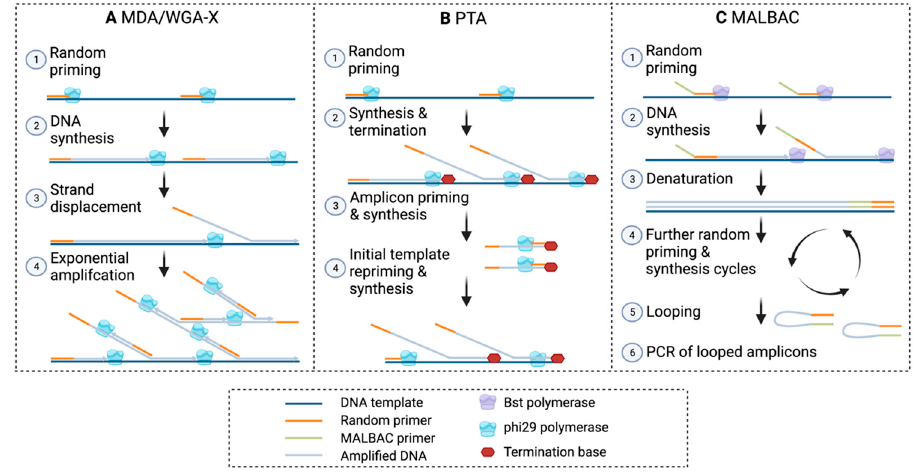
Figure A1. Overview of WGA methods. ( A ) MDA, multiple displacement amplification; WGA-X, whole genome amplification—X. ( B ) PTA, primary template-directed amplification. ( C ) MALBAC, multiple annealing and looping based amplification cycles. Made with Biorender.com.